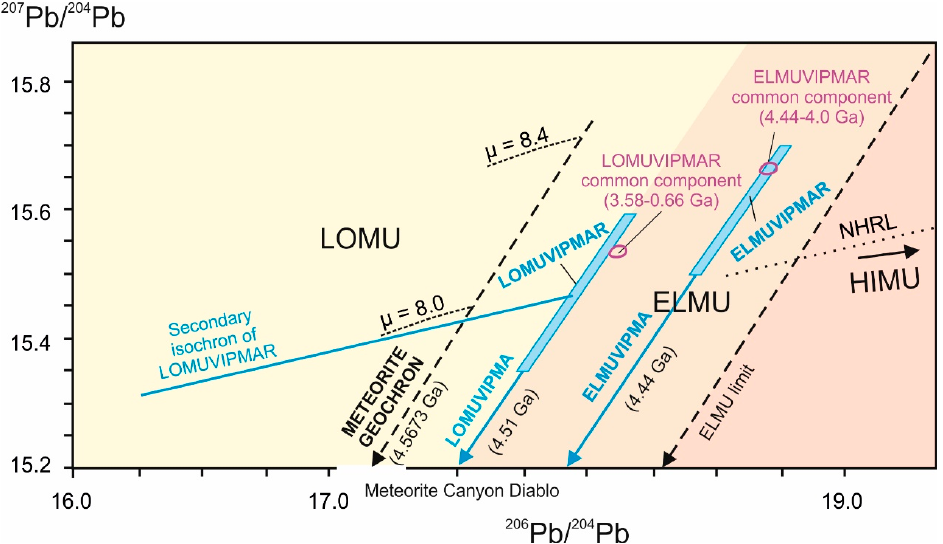
Figure 3. General Pb isotope discrimination of mantle sources for volcanic rocks of Asia on a plot of uranogenic Pb isotope ratios. The empirical geochrons LOMUVIPMA and ELMUVIPMA with slopes corresponding to the ages of about 4.51 and 4.44 Ga are shifted to the right of the geochron, the slope of which corresponds to the age 4.5673 Ga of the highest temperature Ca – Al inclusions of meteorites [83]. Discriminated are the low µ, elevated µ, and high µ (respectively, LOMU, ELMU, and HIMU) compositions. The LOMUVIPMAR and ELMUVIPMAR are determined by ranges of volcanic rocks, derived from the Udokan 1 source and Kunlun – Abaga-Dalenuor sources, respectively. The common components ELMUVIPMAR and LOMUVIPMAR are defined for volcanic rocks of the Kunlun and Tuva 1 — Hangay sources, respectively.